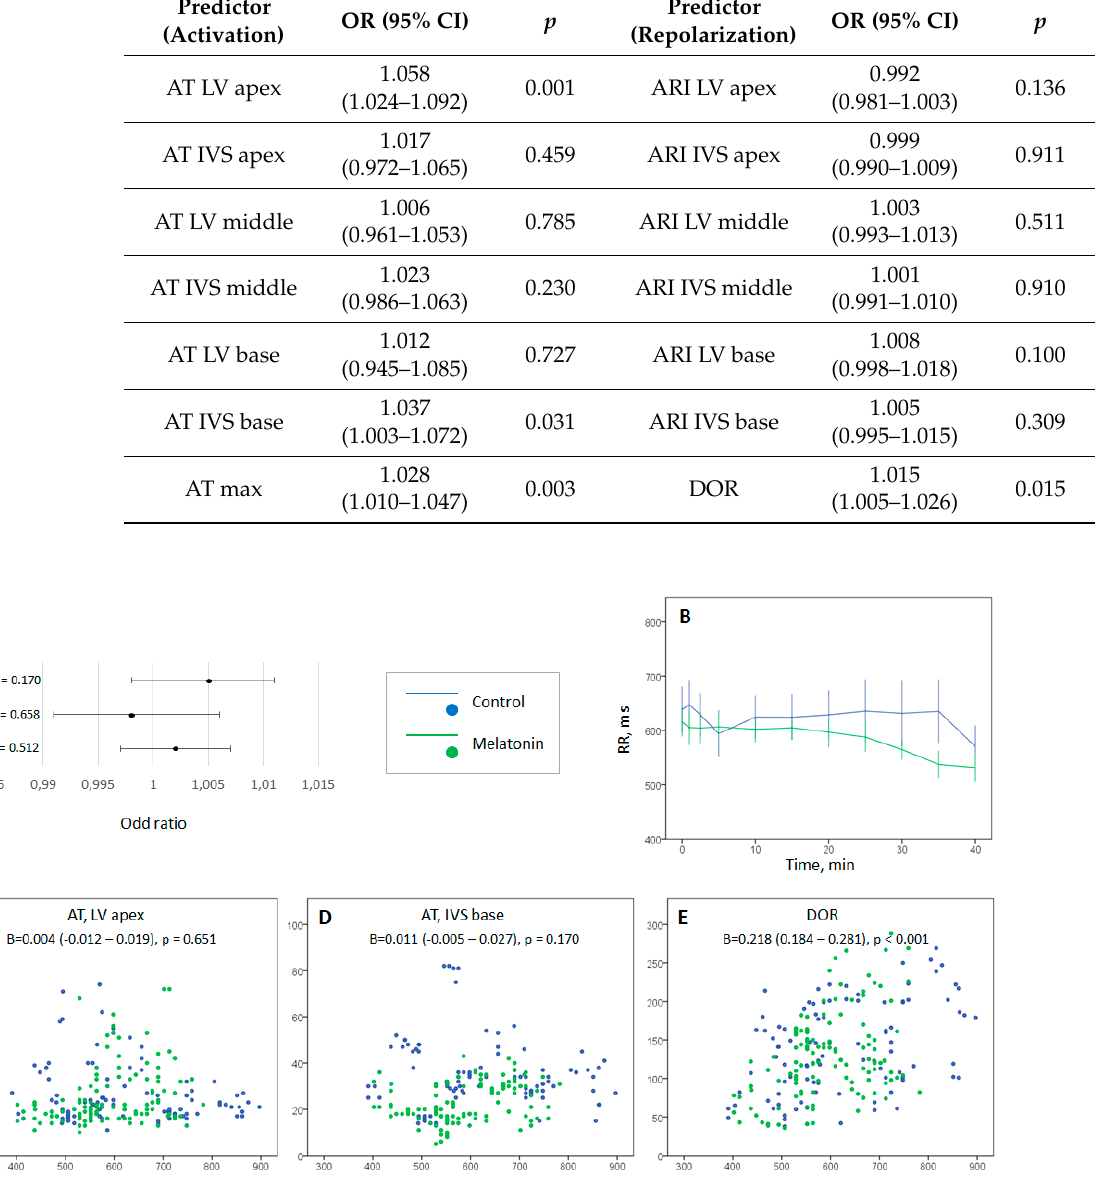
Table 1. Association of VF incidence with activation and repolarization parameters (univariate logistic regression analy- sis).